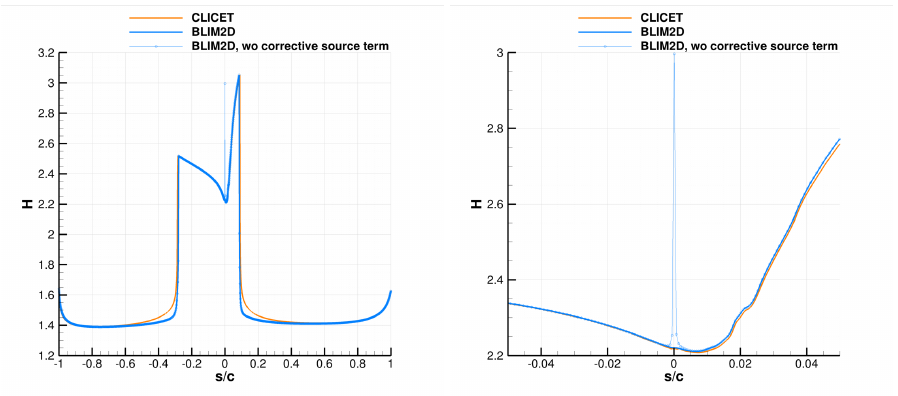
Figure A6. Solution produced by CLICET and BLIM2D for the shape factor H in Case 1 of Table A1. ( Left ): whole airfoil. ( Right ): focus in the vicinity of the stagnation point.